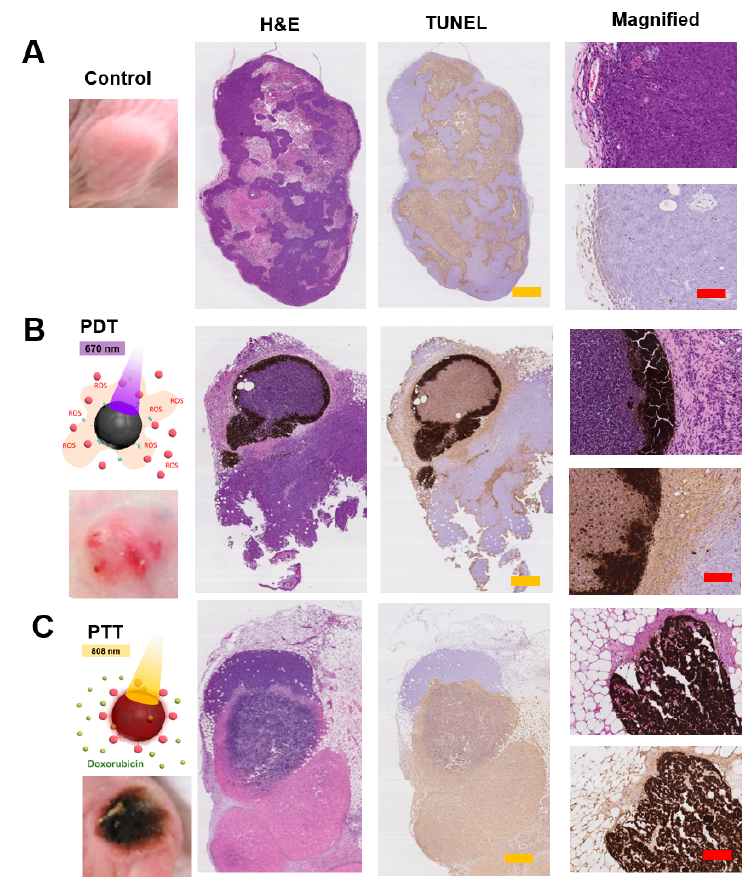
Figure 6. H&E and TUNEL staining of tumors belong to ( A ) control group, ( B ) PheoA-MNPs under PDT (670 nm) and ( C ) Doxo / PheoA-MNPs under PTT (808 nm). Yellow and red scale bars represent PDT (670 nm) and ( C ) Doxo/PheoA-MNPs under PTT (808 nm). Yellow and red scale bars represent 2.0 and 0.4 mm, respectively.